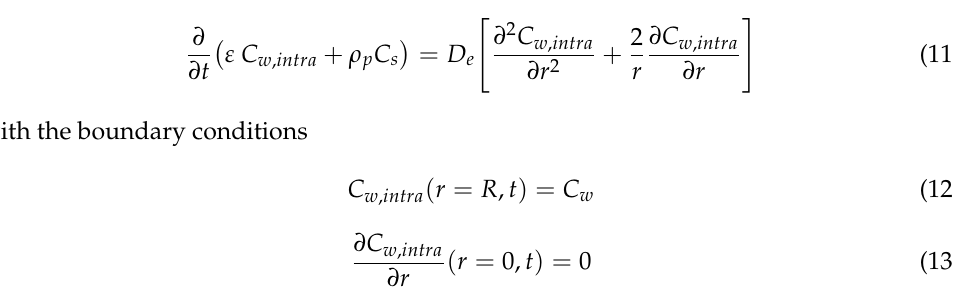
Figure 2. Scheme of mass transfer limited by film diffusion during the first flooding with fixed con- centration at the interface (because the infiltrating water is always contacting fresh material as it advances).